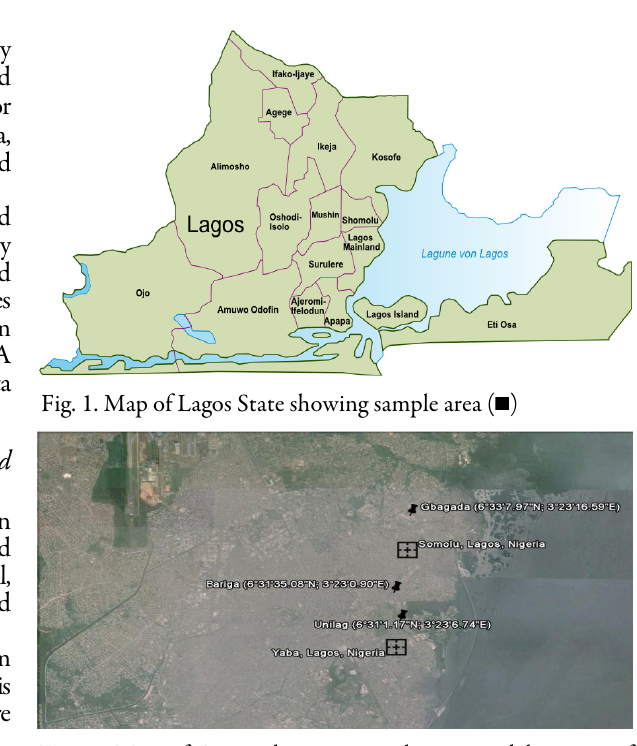
Fig. 2: Map of Lagos showing sample area and location